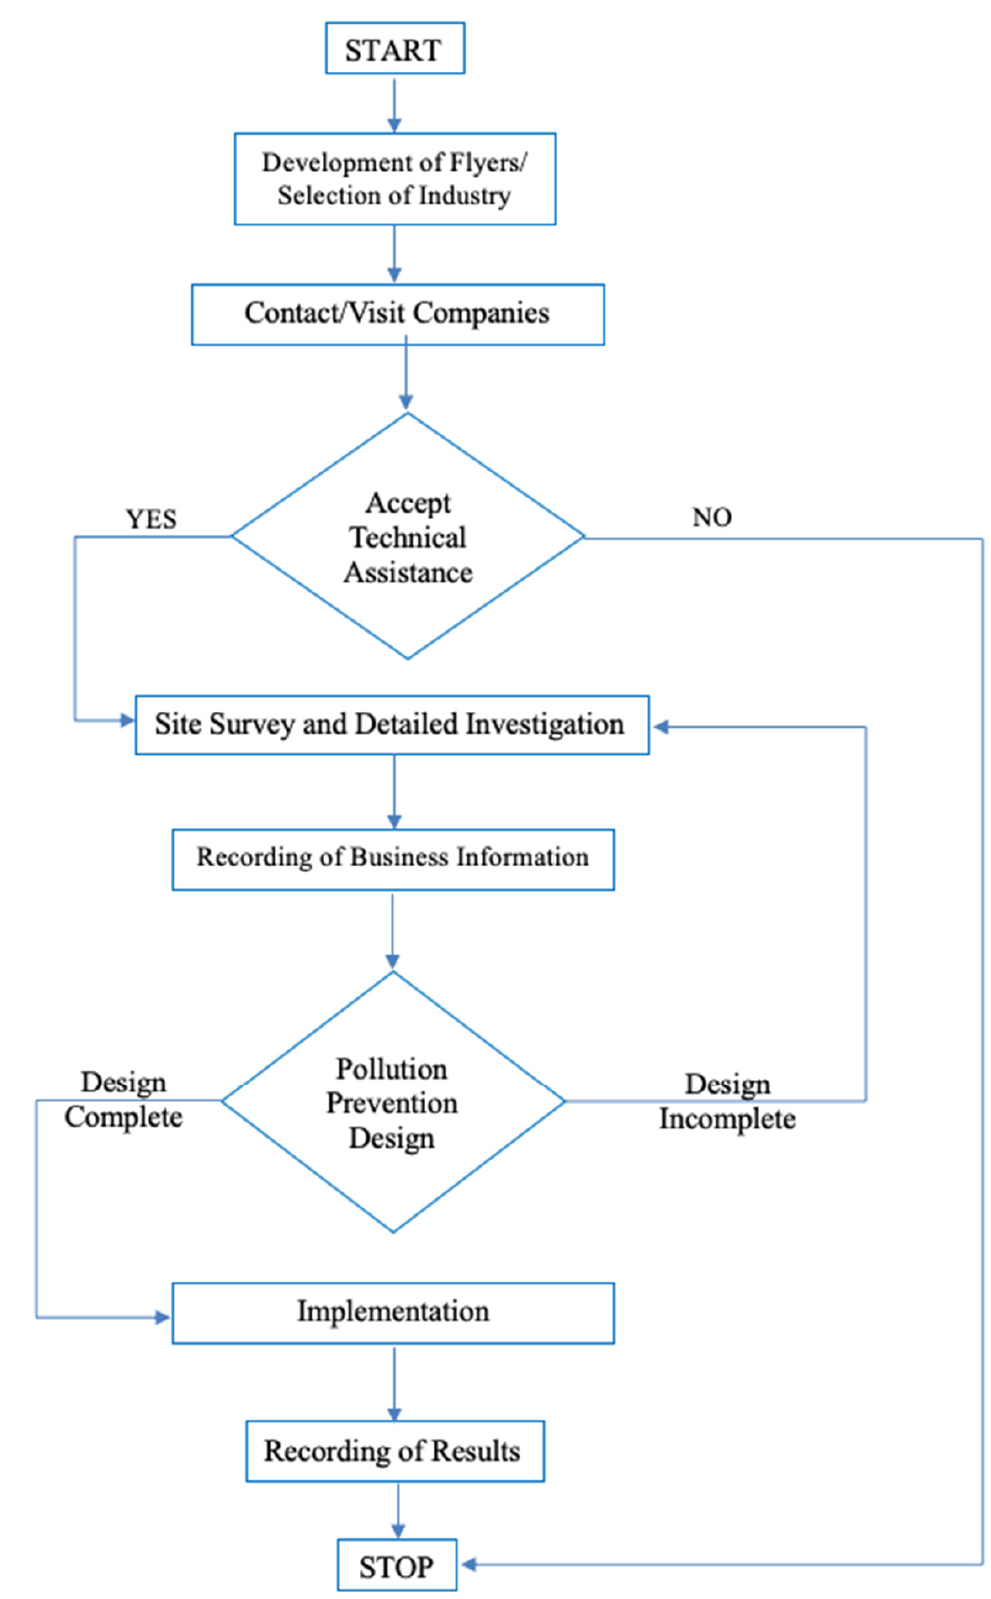
Figure 2. A flow chart showing the methodology adopted in this study.